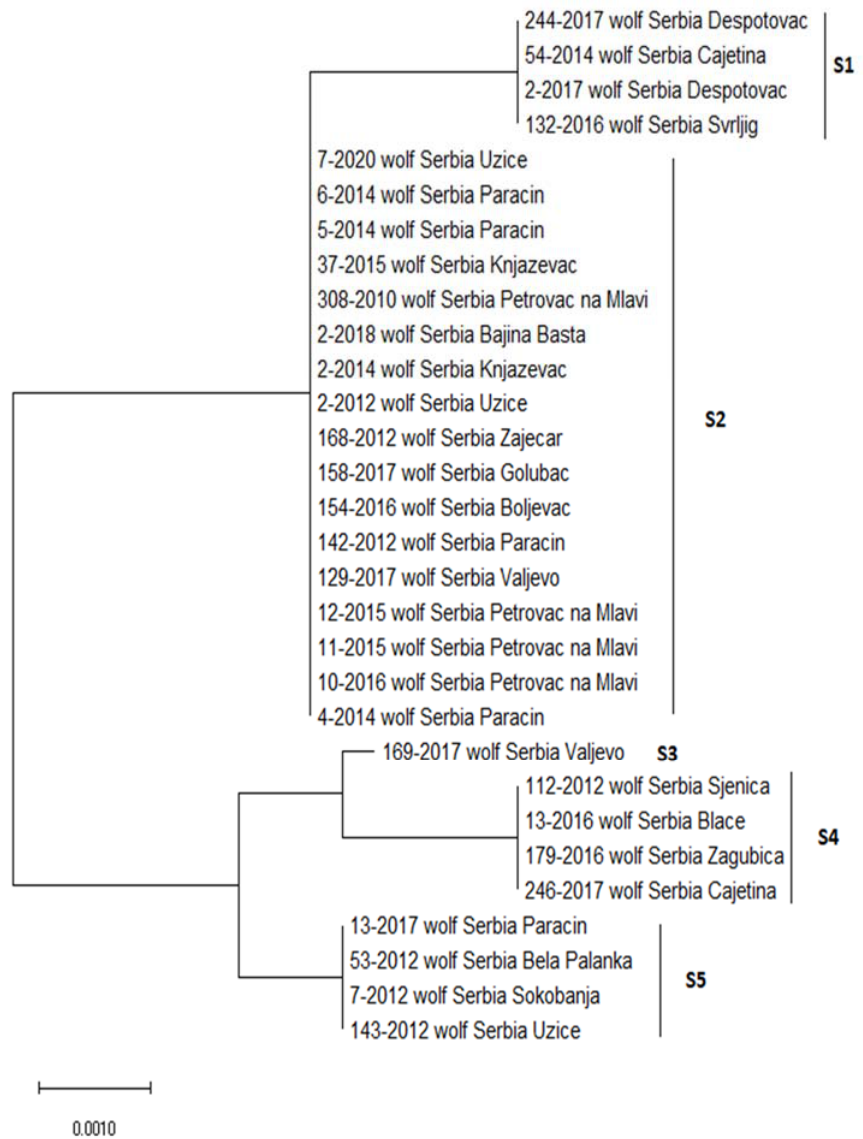
Figure 2. Neighbour ‐ joining analysis of partial 18S rRNA sequences showing the five genotypes of Hepatozoon canis isolates found in this study. Sequence types (S1–S5) are marked by the group number on the right side of the figure. The code numbers and locality are indicated for each animal. Table 2. Alignment of partial sequences of 18S rRNA gene (539 bp) and position of variable sites. Position of the Variable Sequence Type